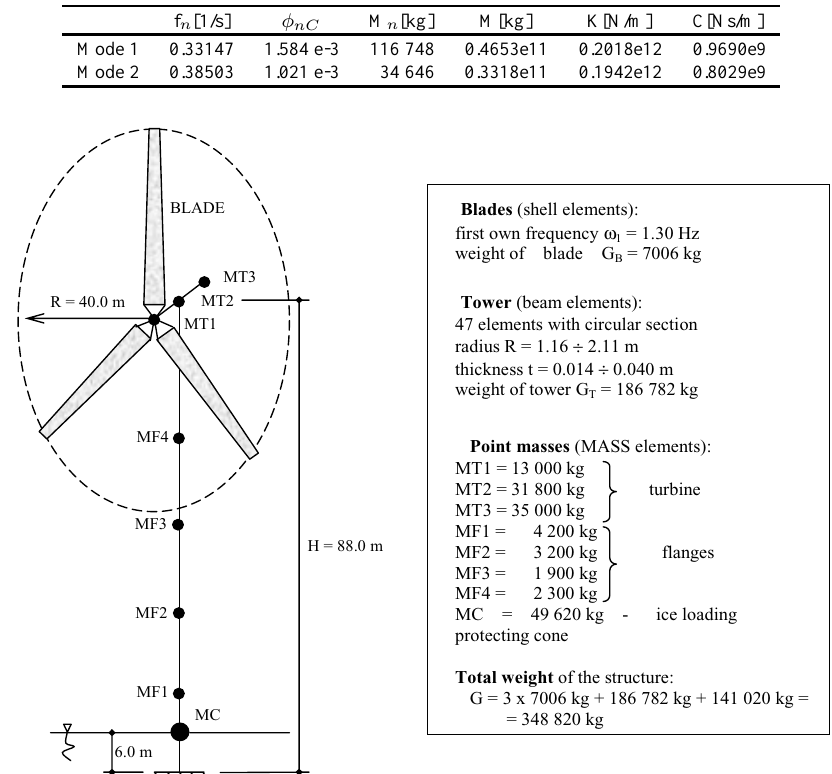
Table 1 Parameters of the 1D model at the water level